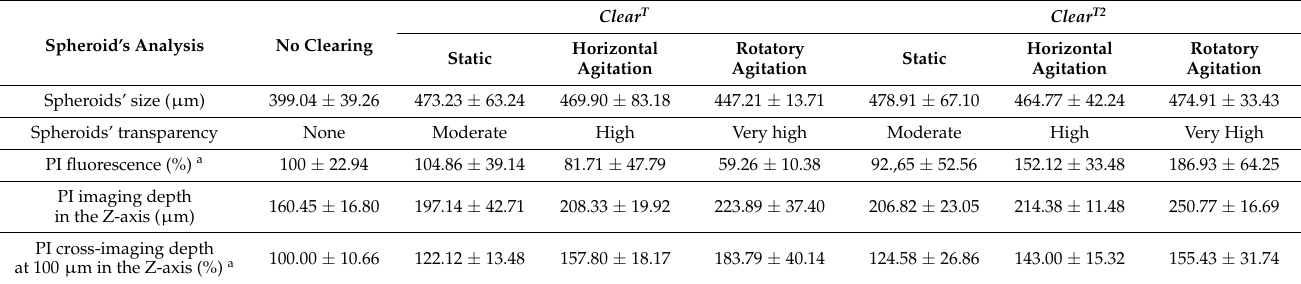
Figure 2. Influence of the immersion conditions used to perform the Clear T ( A ) and Clear T2 ( B ) methods on HFIB spheroids size and transparency. ( A , B ) represent the spheroids’ diameter after they were cleared with Clear T and Clear T2 methods under static, horizontal and rotatory agitation, normalized to the average diameter of non-cleared spheroids (388.97 ± 42.94 µ m). Optical transparency of a non-cleared spheroid and spheroids cleared by using Clear T and Clear T2 methods under static, horizontal agitation, and rotatory agitation conditions ( C ). Spheroids were imaged on crosshatched backgrounds for the relative differences in transparency be noticeable. Scale bars correspond to 200 µ m. Data are presented as mean ± S.D.; n = 7, p < 0.05, n.s.—non-significant. Table 1. Overview of Clear T and Clear T2 application in PI-stained spheroids by using different incubation conditions of the clearing